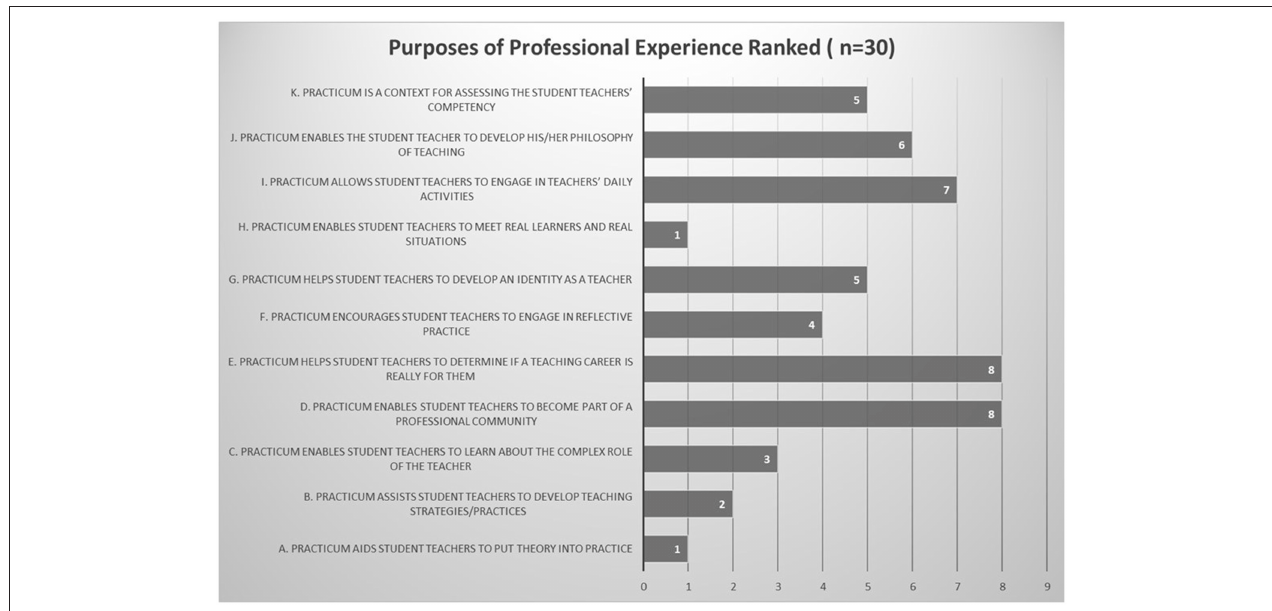
FIGURE 1 | Ranked purposes by total numerical value ( n =